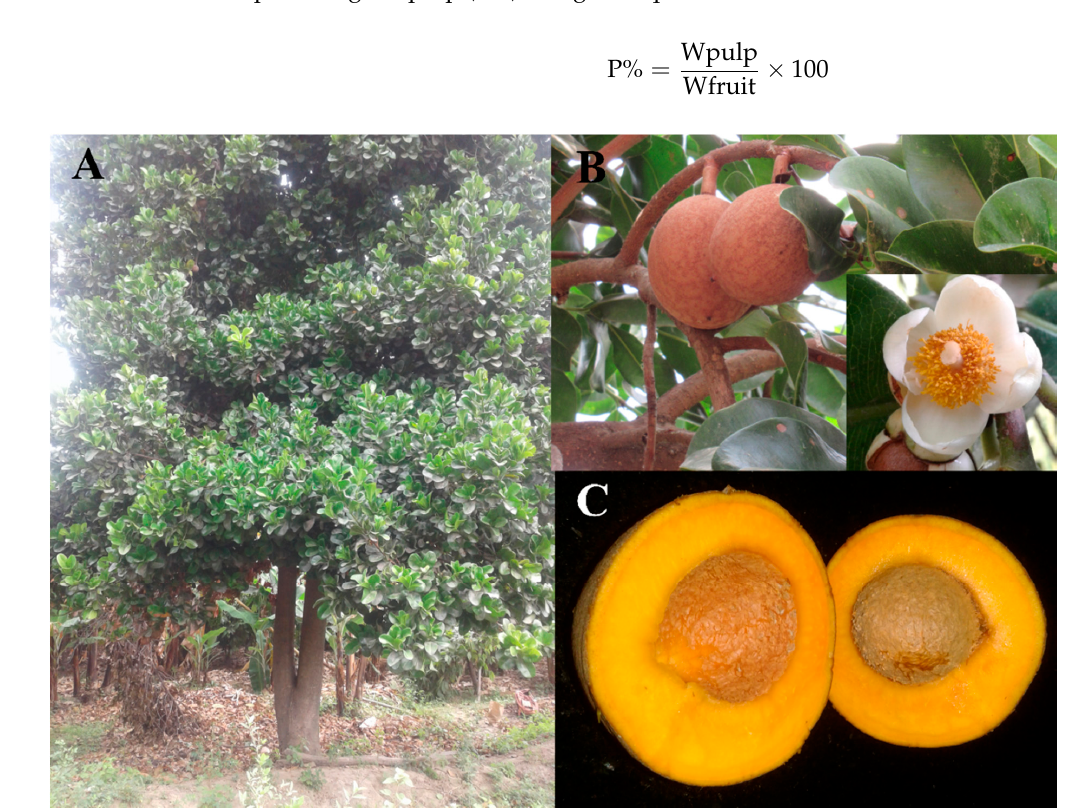
Figure 2. ( A ) Adult tree of Mammea americana L. (Calophyllaceae). ( B ) Detail of the fruits and leaves of mamey, with insertion of detail of the flower. ( C ) Cross sections of halved mamey apple fruit, M. americana .